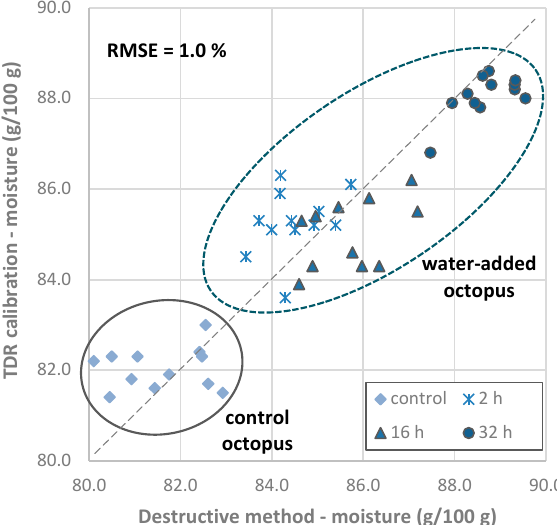
Figure 6. Validation results of Octopus vulgaris samples obtained using the TDR calibration for quantitation of moisture content vs. moisture content determined by the classic destructive method (predicted vs. actual values). The coefficient of determination R 2 was 0.796. Abbreviations: RMSE, root mean squared error.